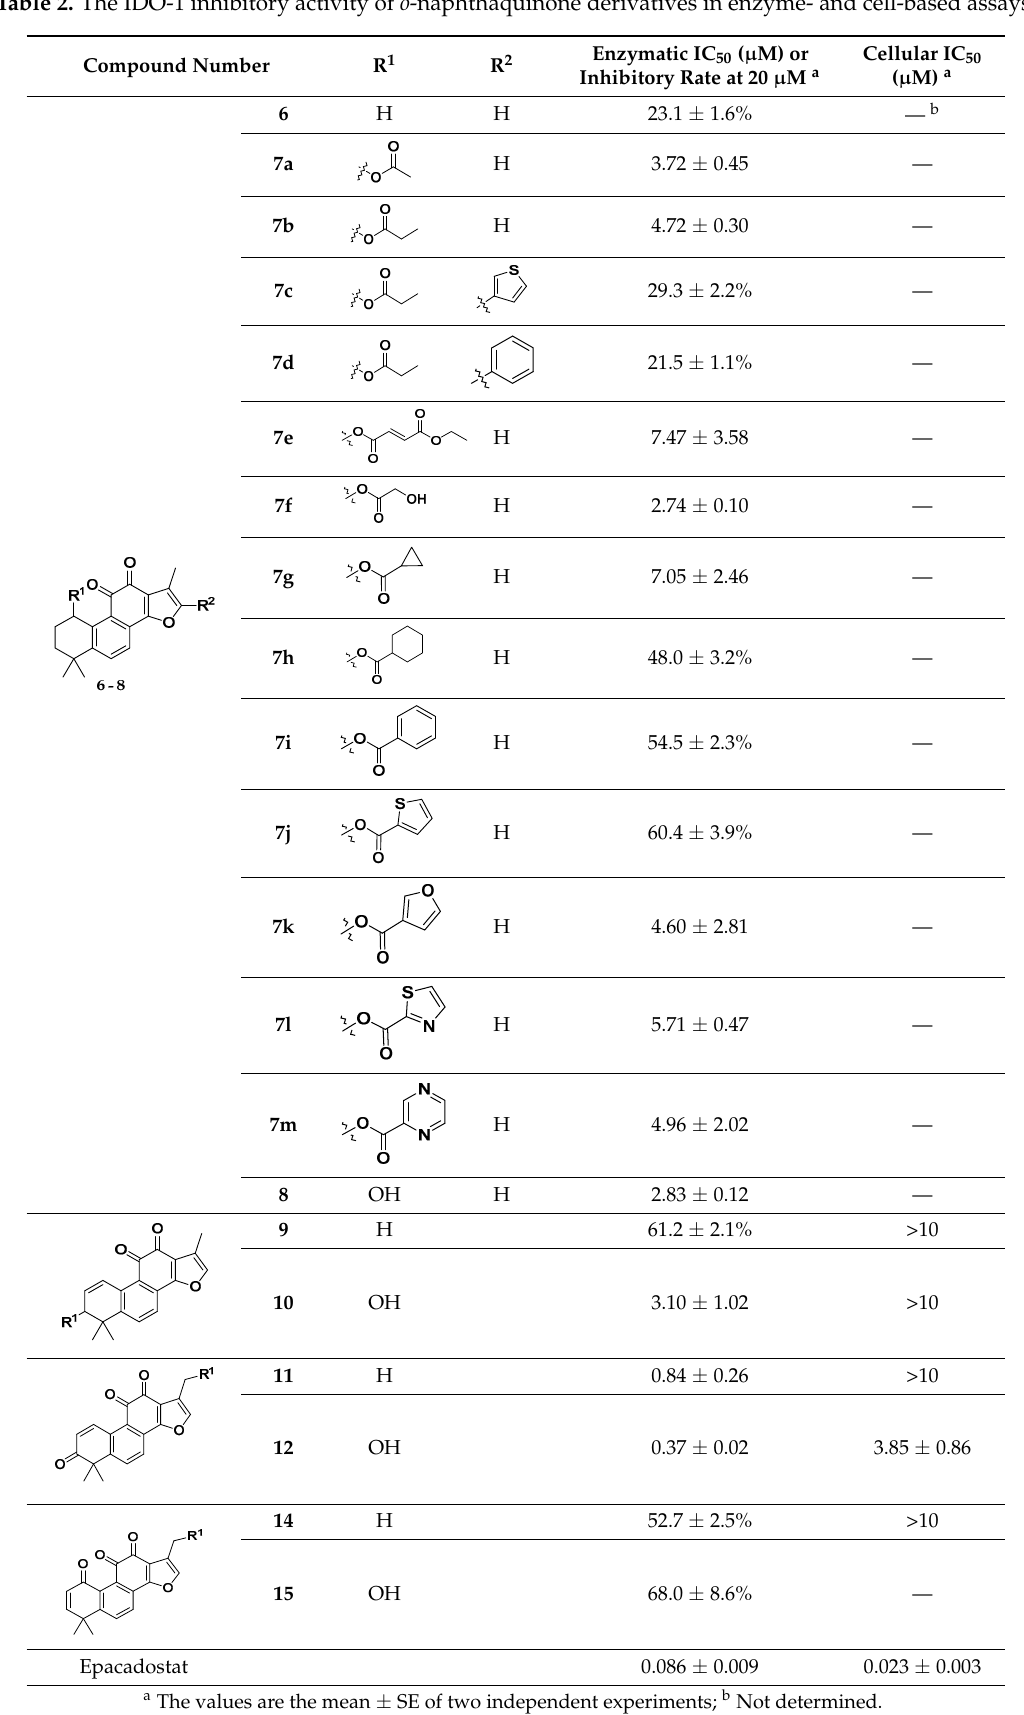
Table 1. Structures of acyloxy derivatives 7a – m. Table 2. The IDO-1 inhibitory activity of o -naphthaquinone derivatives in enzyme- and cell-based assays. Compound Number Molecules 2019 , 24 , x